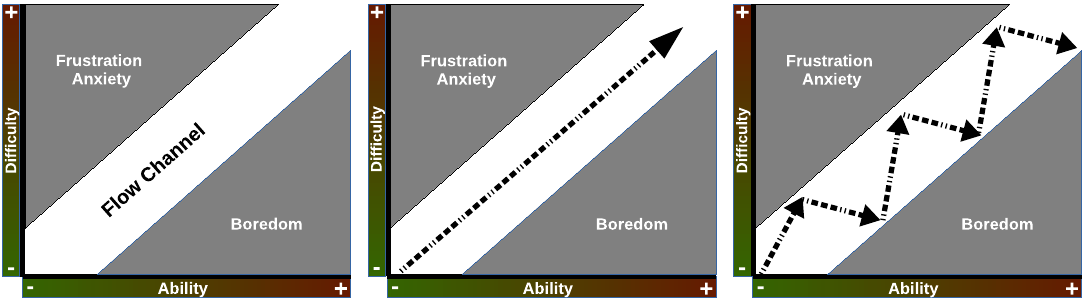
Figure 2. ( Left ) The flow channel. ( center ) Linear incremental difficulty design that perfectly matches abilities. ( right ) Rhythmic incremental difficulty